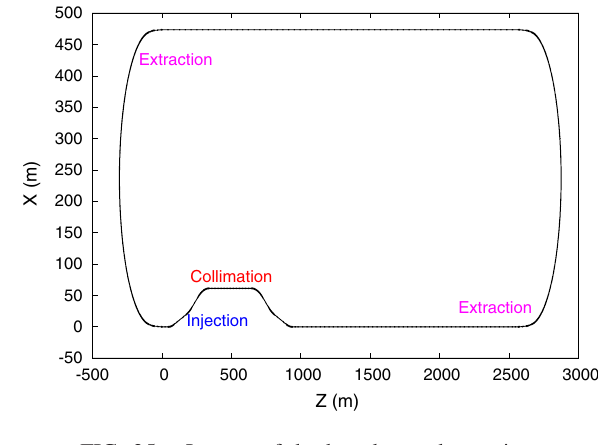
FIG. 35. Layout of the beta-beam decay ring.